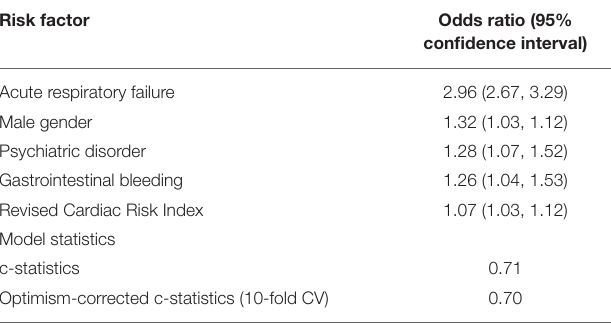
Frontiers in Medicine |